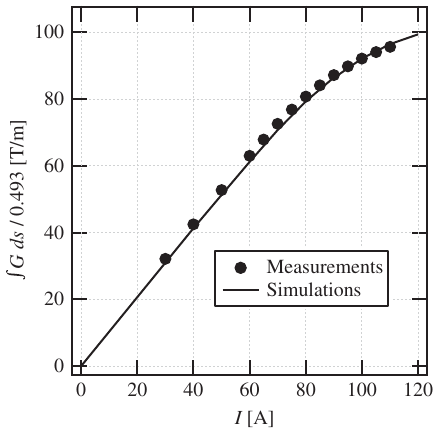
FIG. 17. Quadrupole gradient normalized by a 493 mm magnetic length. The gradient has been measured with circular measurements at 12.4 mm radius.